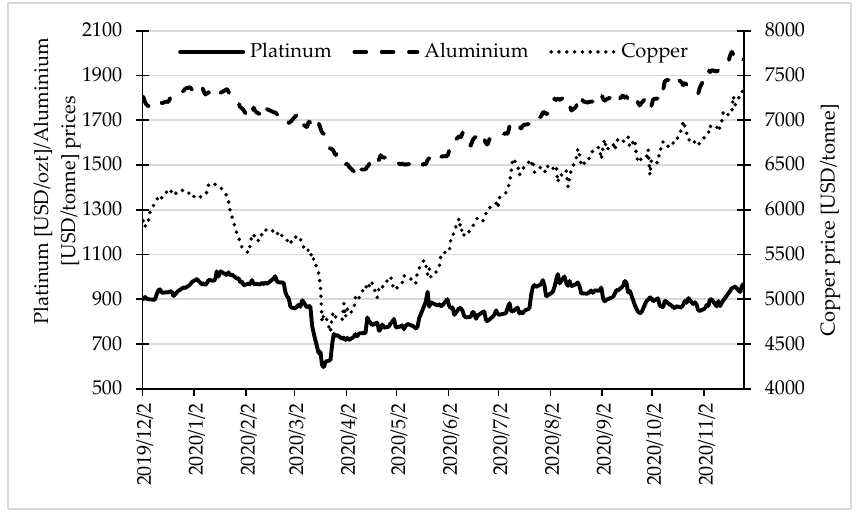
Figure 5. Wheat, palm oil, and corn prices in the period 2 December 2019–26 November 2020. Source: own elaboration on the basis of data from www.stooq.pl (accessed on 18 February 2021).